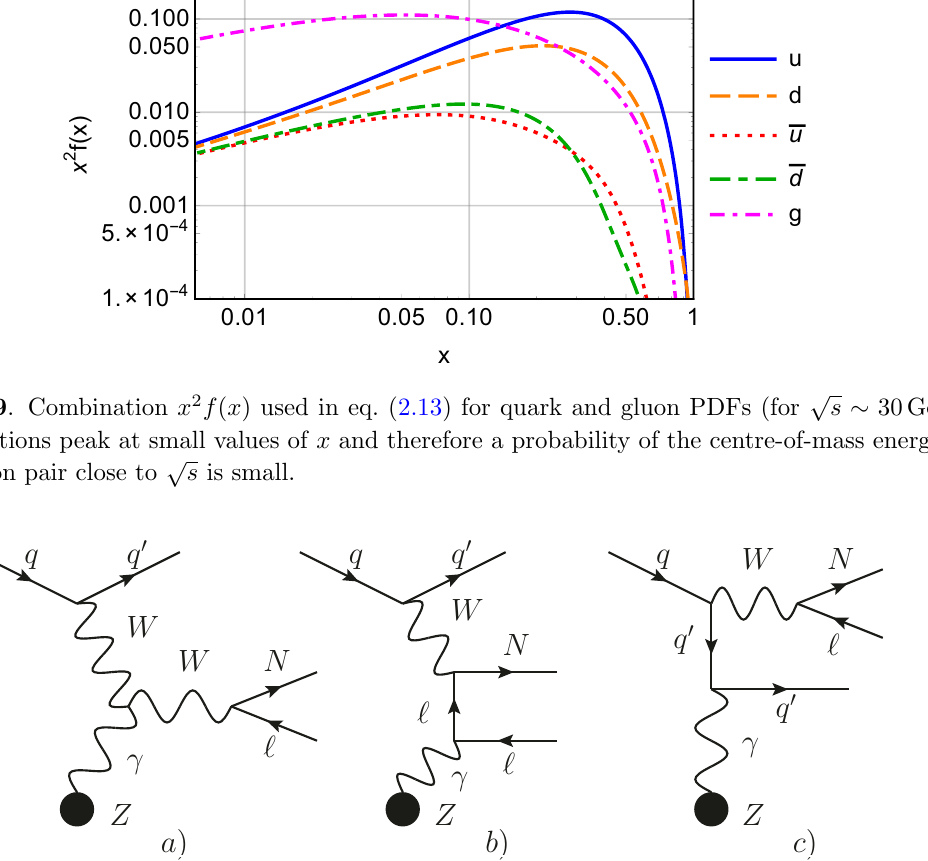
Figure 10 . Possible Feynman diagrams for the HNL production in the proton coherent scattering o(cid:11) the